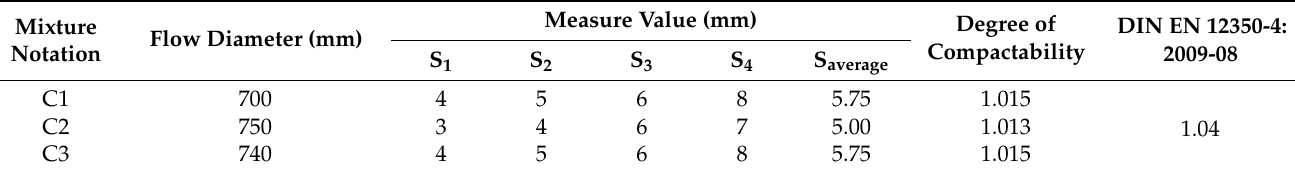
Figure 11. Testing the consistency of fresh concrete. ( a ) Container and vibration table, ( b ) Com- pacted concrete. Table 8. Measurement of the compactness of fresh concrete.